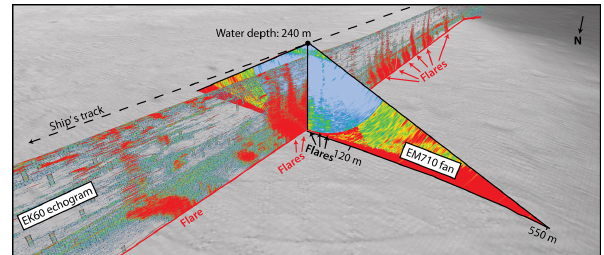
Figure 4. Composite figure illustrating the appearance of flares in the single-beam EK 60 echosounder and in the multibeam EM 710 echosounder. Flares can be traced in the central part of the EM 710 fan (45 ◦ to each side); in this example obtained in 240m water depth, the across track width is 120m to each side. Beyond that limit, the noise is too high to reliably map flares.